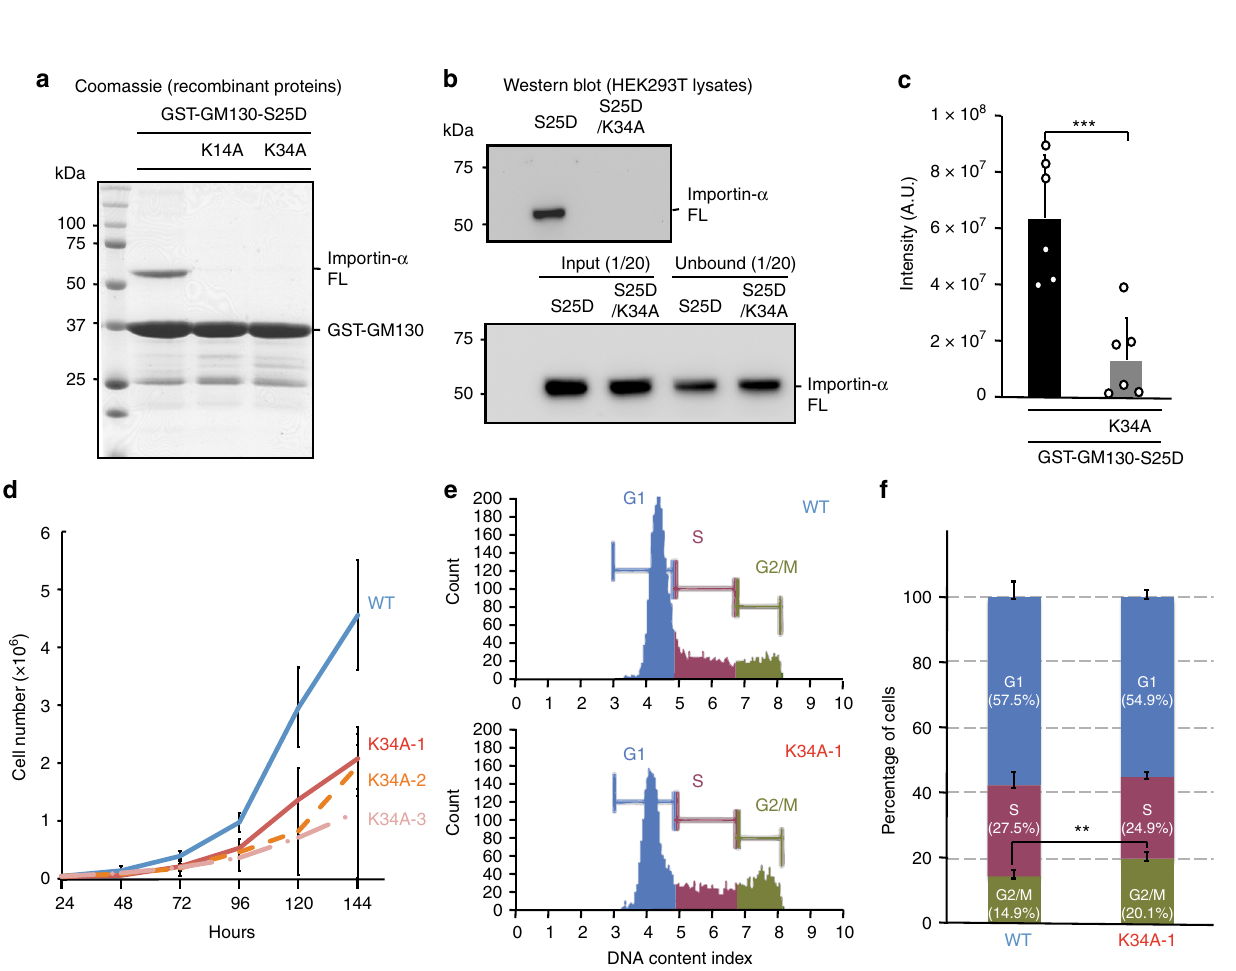
Fig. 5 GM130 K34A mutation causes proliferative defects and G2/M arrest. a GST pulldown assays of Importin- α FL with GM130-S25D mutants. GST- fused GM130-S25D mutants were incubated with recombinant Importin- α FL. GST-bound samples were analyzed by SDS – PAGE and stained with Coomassie blue. b GST-fused GM130-S25D and GM130-S25D/K34A were incubated with HEK293T cell lysates. GST-bound samples were analyzed by SDS – PAGE followed by Western blotting using an Importin- α antibody. 1/20 of whole cell lysate (input) and of the total unbound proteins (unbound) are indicated. c Analysis of Importin- α FL pulled down by GM130-S25D from cell lysates. Band intensities of Importin- α FL from Western blotting in b were used to determine the averages of bound protein. Data represent mean ± standard deviation from more than three independent experiments. Differences were assessed statistically by two-tailed Student ’ s t- test; *** p < 0.005. d Growth curves for wild-type (blue) and three K34A heterozygous mutant HEK293T (red, orange, and pink) cell lines. Equal numbers of cells were plated, and cells were counted each day for 6 consecutive days after plating. Data represent mean ± standard deviation from three independent experiments for each cell line. e , f Wild-type and K34A mutant cell lines were subjected to DNA content analysis. e DNA content of the wild-type (upper) and a K34A mutant cell line (lower) was measured using fl ow cytometry. Numbers of cells in the G1, S, and G2/M phases are shown in blue, purple, and dark green, respectively. f Percentages indicate cell cycle distributions of wild-type and mutant cells. Percentages of cells in the G1, S, and G2/M phases are represented by blue, purple, and dark green bars, respectively. Data represent mean ± standard deviation from three independent experiments. Differences were assessed statistically by two-tailed Student ’ s t -test; ** p < 0.01 for the G2/M phase in the wild-type and mutant cell line NATURE COMMUNICATIONS| (2019) 10:4307